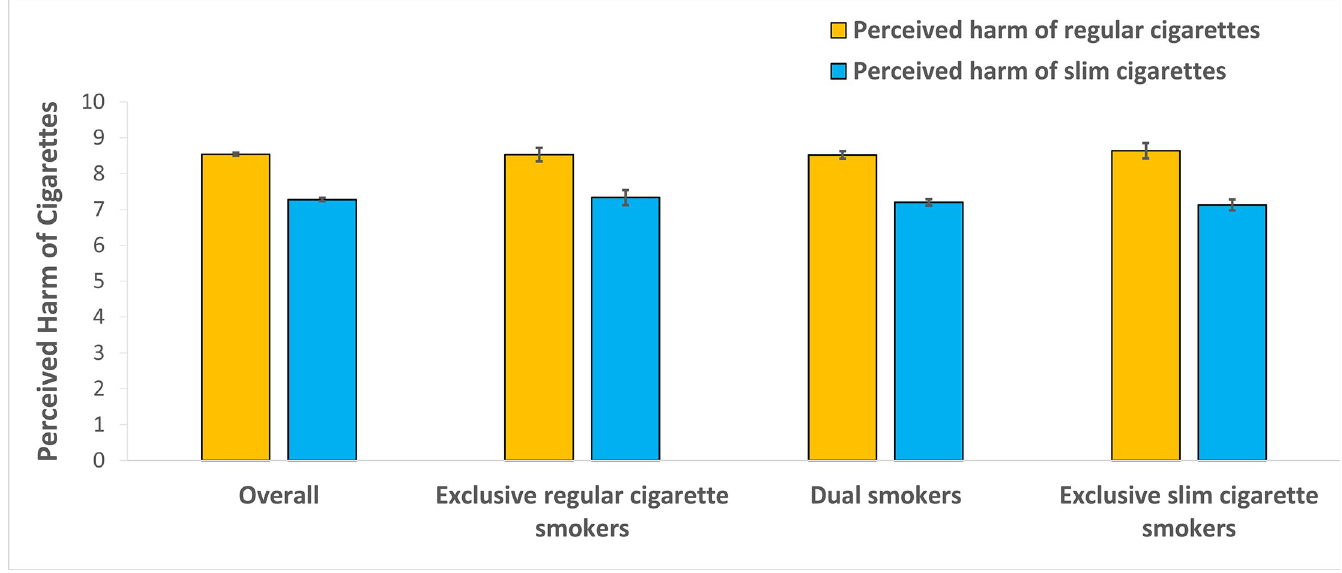
Fig 1. The perceived harm of regular and slim cigarettes among current smokers (10-point likert scale).